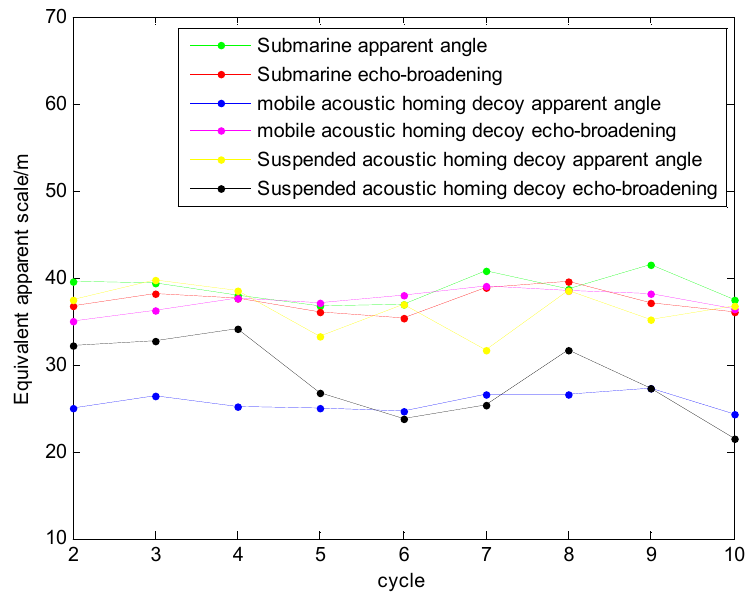
Figure 14. The equivalent apparent scale of each cycle.